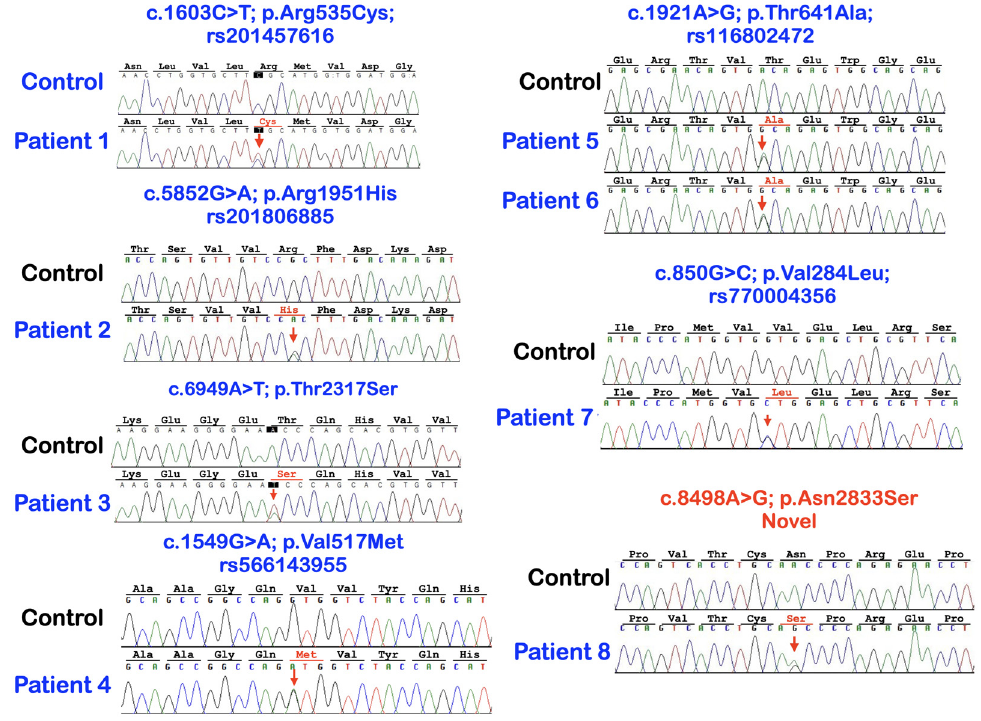
Figure 1. Sequence chromatograms of patients with heterozygous missense variants in FREM2 gene. Six variants are recurrent and two are novel.